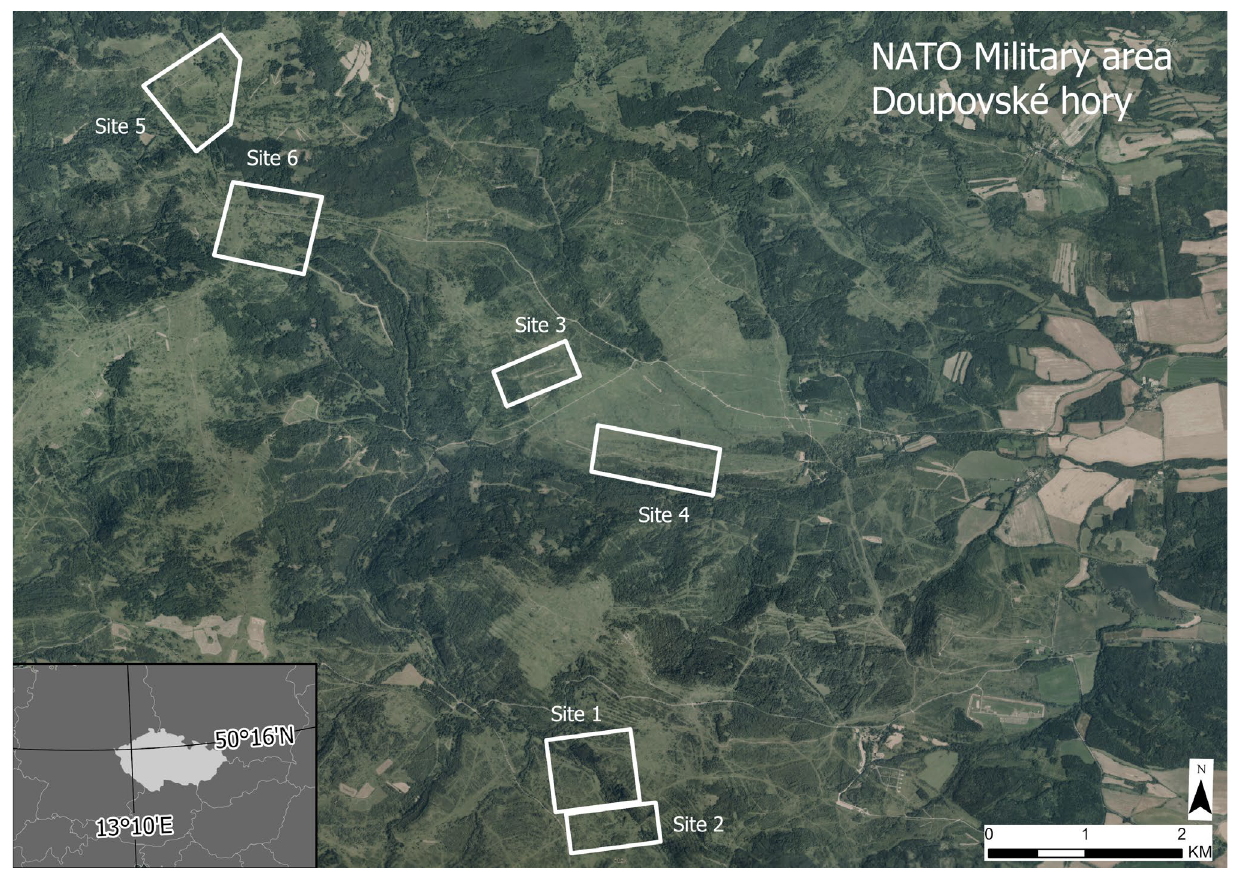
Figure 1. Study site overview.